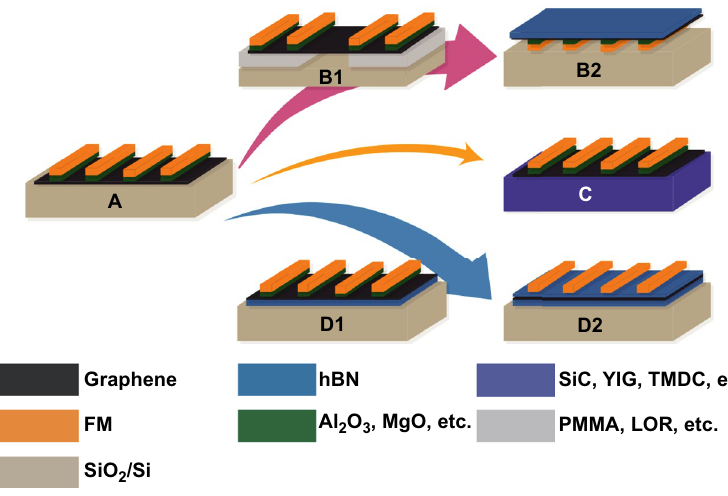
Fig. 6 Development trend of spin device structure (graphene as an example). A Non‑local spin valve with oxide tunnel barriers, B with sus‑ pended graphene, C with a different substrate, D with hBN as encapsulation or tunnel barrier